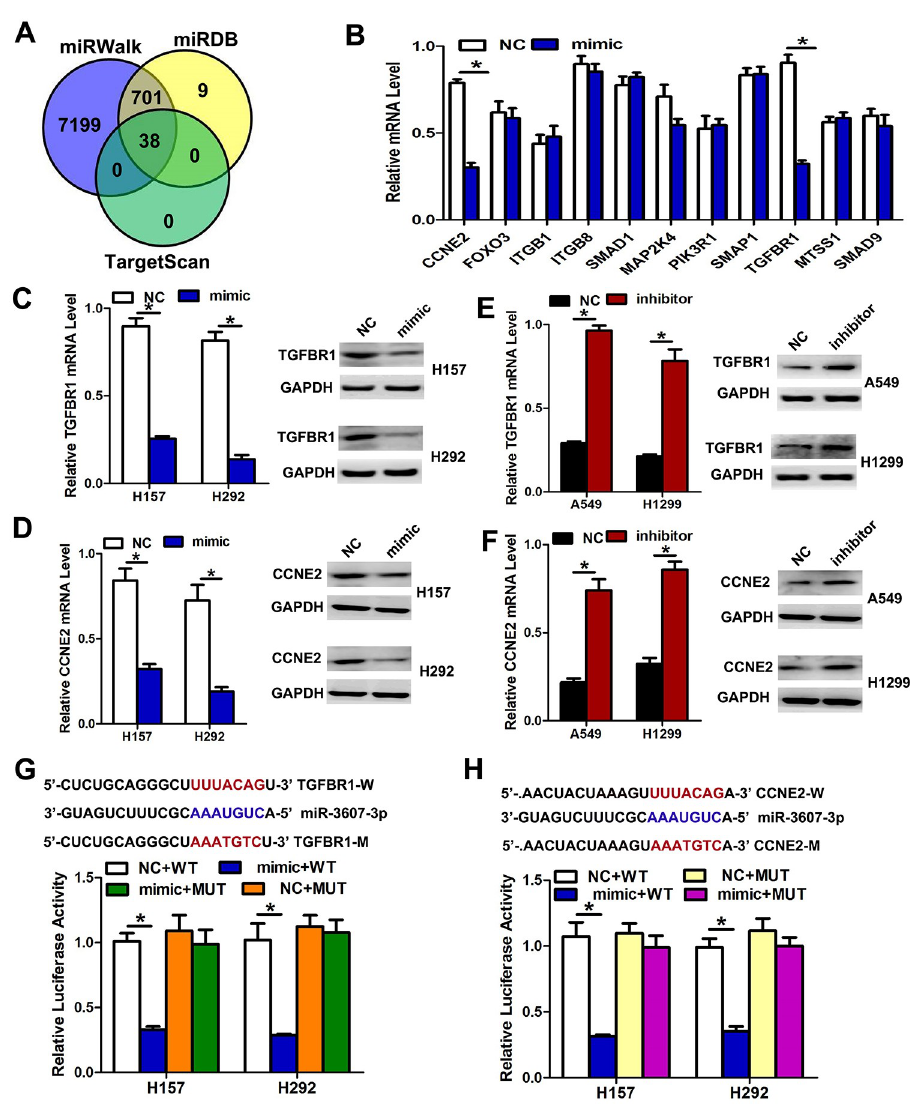
Fig 5. TGFBR1 and CCNE2 are two direct target genes of miR-3607-3p. (A-B) TGFBR1 and CCNE2 were identified as potential regulatory targets of miR-3607-3p by considering the downregulation genes using prediction tools and the qRT-PCR method. (C-D) The expression levels of TGFBR1 and CCNE2 mRNA and protein were measured by qRT-PCR and western blot analysis using GAPDH as the loading control after transfection of miR-3607-3p mimic in H157 and H292 cell lines, respectively. (E-F) The expression levels of TGFBR1 and CCNE2 mRNA and protein were measured by qRT-PCR and western blot analysis using GAPDH as the loading control after transfection of miR-3607- 3p inhibitors in A549 and H1299 cell lines, respectively. (G-H) Dual-luciferase reporter assay. The relative luciferase activity was normalized to the Renilla luciferase activity after co-transfection of cells with miR-3607-3p mimic and pmiR-RB-REPORT construct containing WT or MUT TGFBR1 and CCNE2 3’-UTR region in H157 and H292 cell lines. Data are presented as means ± standard deviation from triplicate experiments. � , P < 0.05.